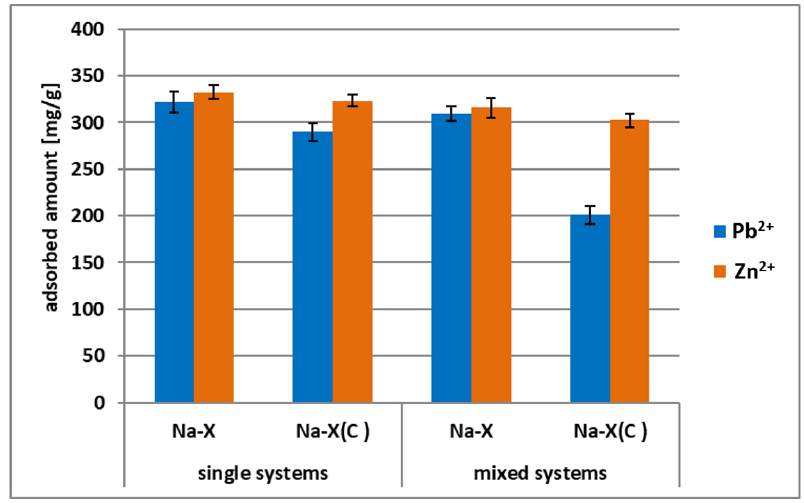
Figure 9. Comparison of adsorbed amounts of Pb 2+ and Zn 2+ on Na-X and Na-X(C) in the mixed systems, in an equilibrium state at pH 5.